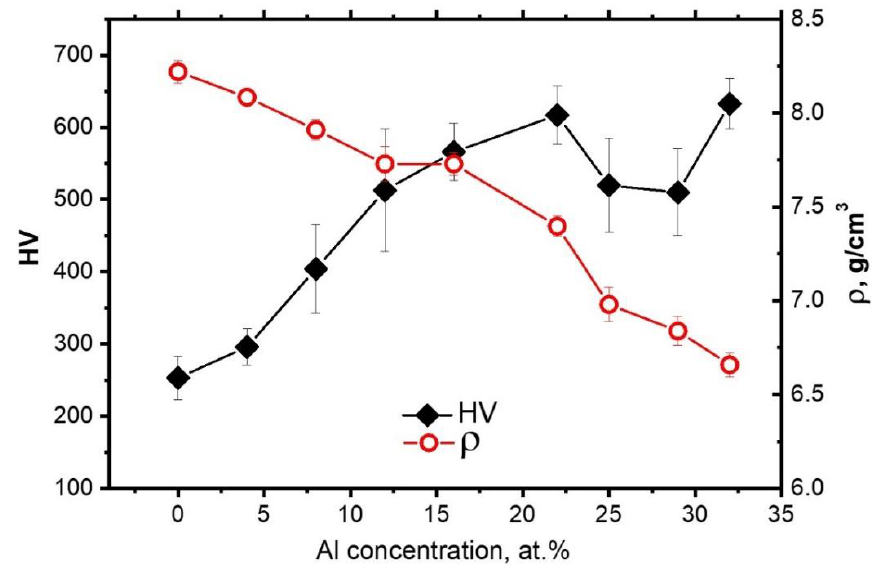
Figure 10. Microhardness and density of the alloys in dependence on Al concentration.